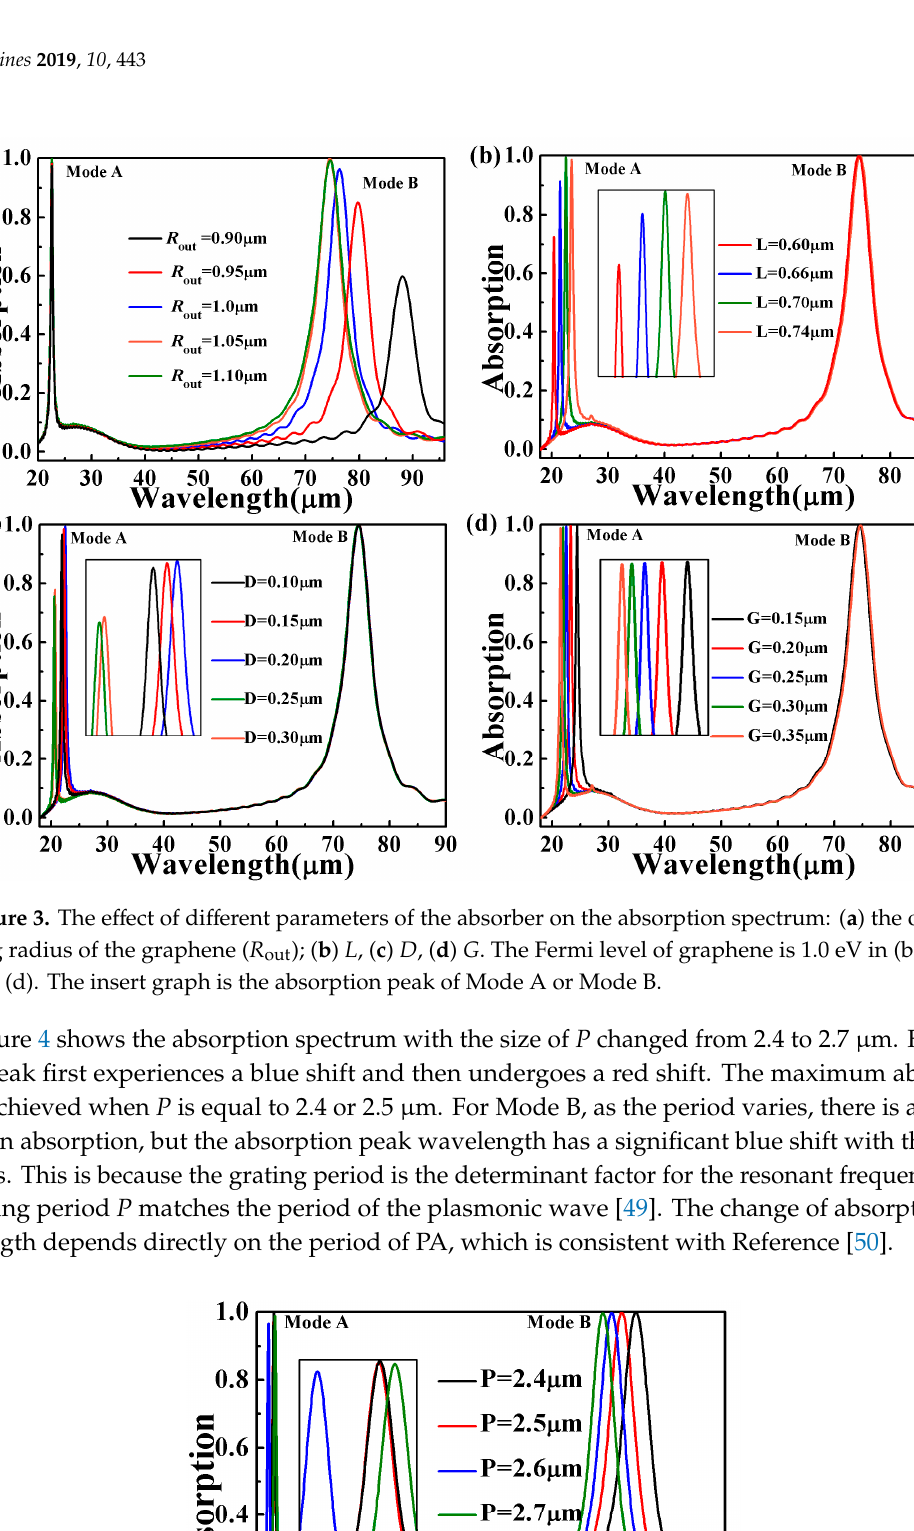
Figure 4. The absorption spectra of the proposed structure with different period P . The insert graph is the absorption peak of Mode A.